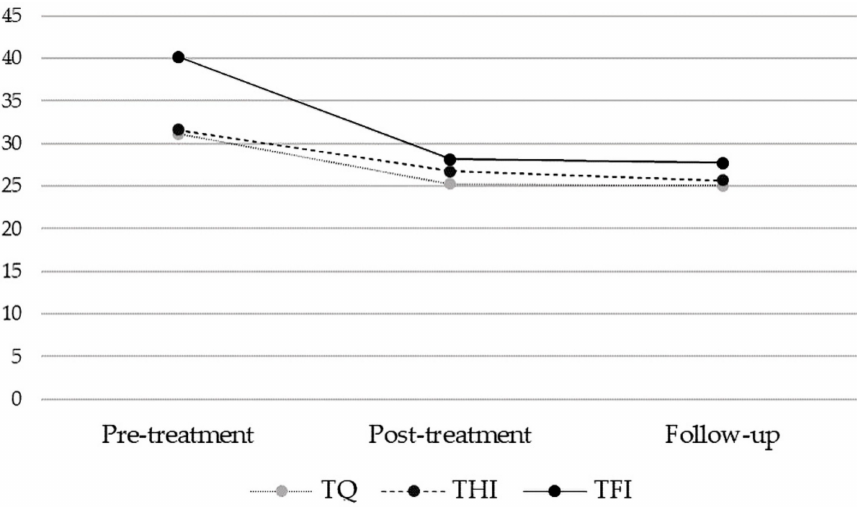
Figure 3. Treatment-related effects on three tinnitus-related distress measures in the pooled total sample ( n = 150) at pre-treatment, post-treatment, and follow-up. All measures significantly improve from pre- to post-treatment and pre-treatment to follow-up with small (TQ, THI) or medium effect sizes